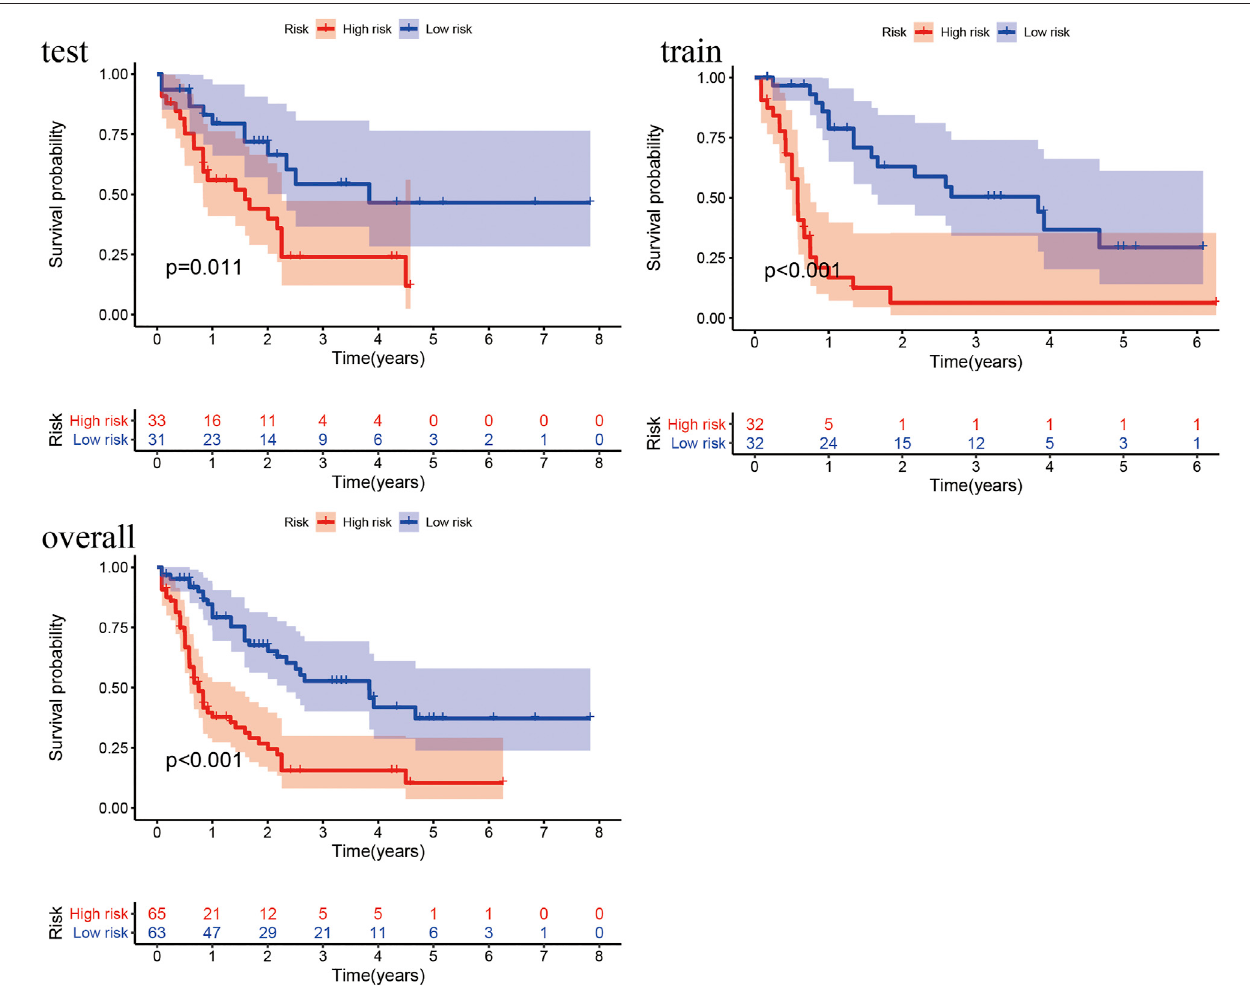
FIGURE4| Kaplan – Meiercurvesofhigh-andlow-riskgroupsinthetrain,test,andoverallgroups.TheX-and Y -axesrepresentthetimeandprobabilityofsurvival, whereas the red and blue lines represent the high- and low-risk groups, respectively.